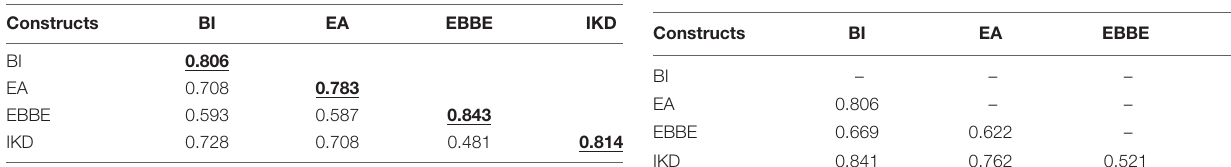
TABLE 3 | Discriminant validity (Fornell-Larker-1981 criteria). TABLE 4 | Discriminant validity